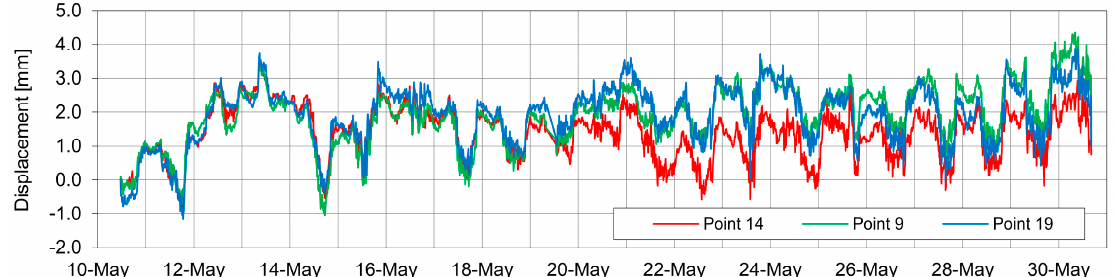
Figure 4. Raw radar observations of the displacements for three selected points (no. 9, 14, 19) on the embankment.